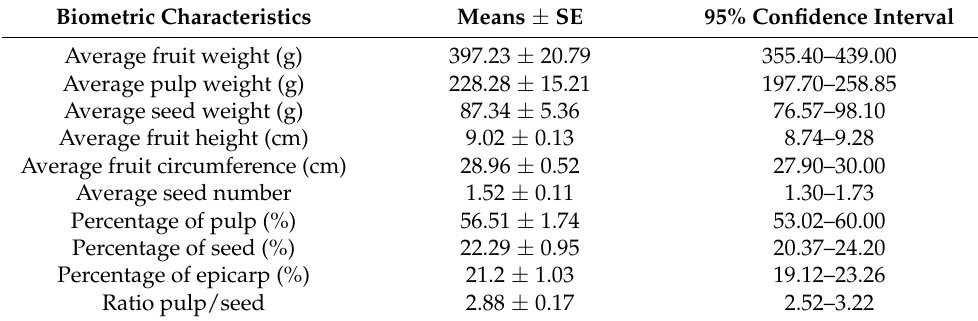
Table 3. Biometric characteristics of fruits with T. pavoniformis populations (n = 50